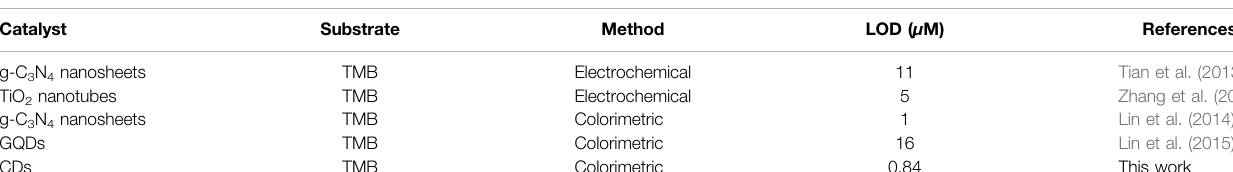
TABLE 3 | Comparison of various methods for detection of the glucose. Catalyst